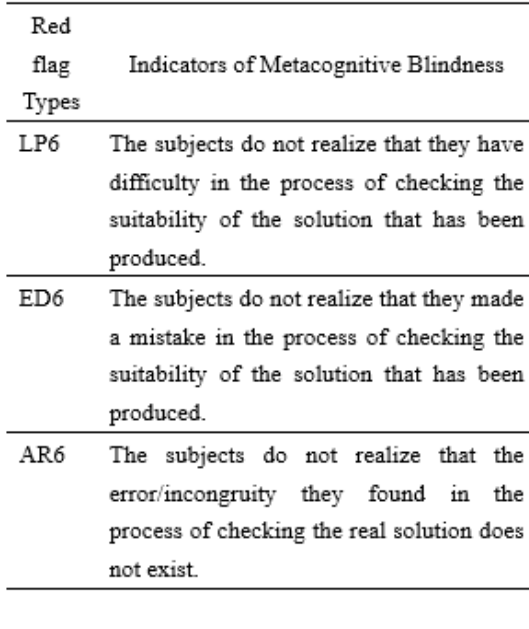
Table 6. Indicators of Metacognitive Blindness at the Verification Phase